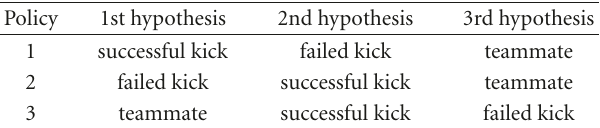
Table 3: The multihypothesis tracking policies tested in 2D